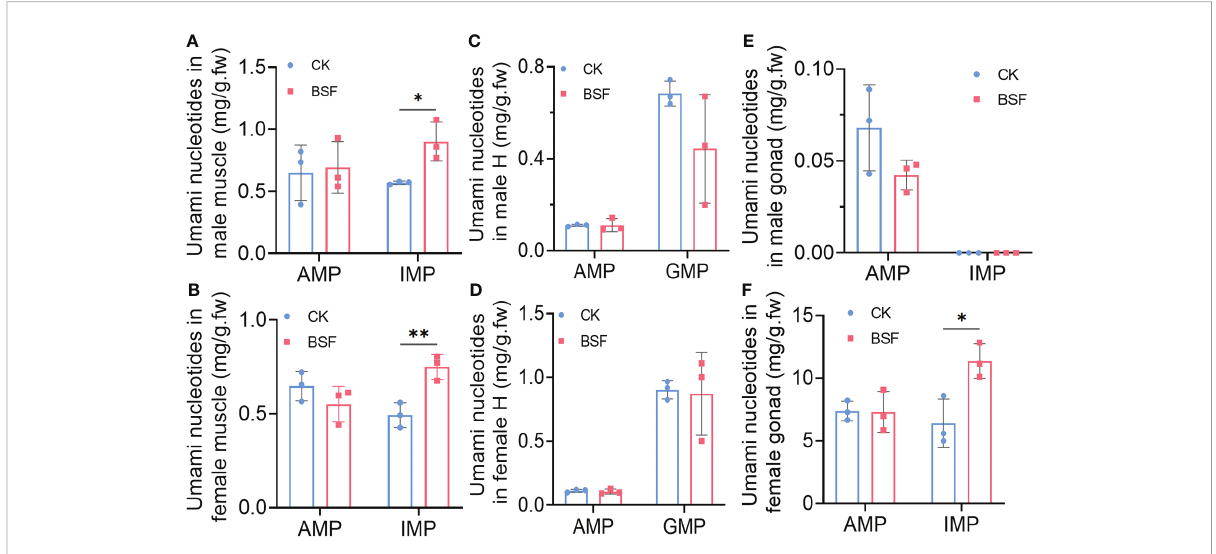
FIGURE 4 Effects of BSFL feeding on umami nucleotide levels in edible tissues of mitten crabs. Umami nucleotide levels in male and female muscles (A, B) ), hepatopancreas (C, D) , and gonads (E, F) . CK, control group; BSF, experimental group. H, hepatopancreas; AMP, adenosine monophosphate; IMP, inosine monophosphate; GMP, guanosine monophosphate. * P ≤ 0.05; ** P ≤ 0.01. n =